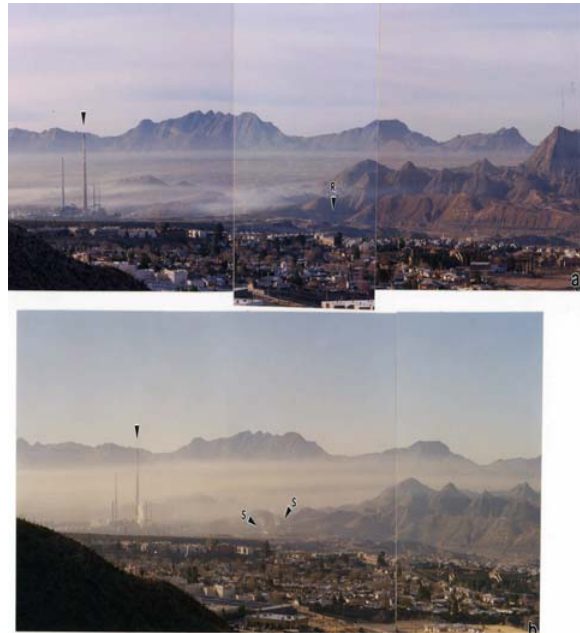
Figure 11: Early morning view (southwest) of particulate/smoke inversion on the El Paso, TX USA/Juarez, Mexico border. (a) December, 2004. Arrow at left denotes reference at Asarco stack. R demotes the Rio Grande River. Juarez mountains are in the background. El Paso and Juarez city centers are at left out of view. (b) December, 1998. Arrows marked S show small smoke sources.